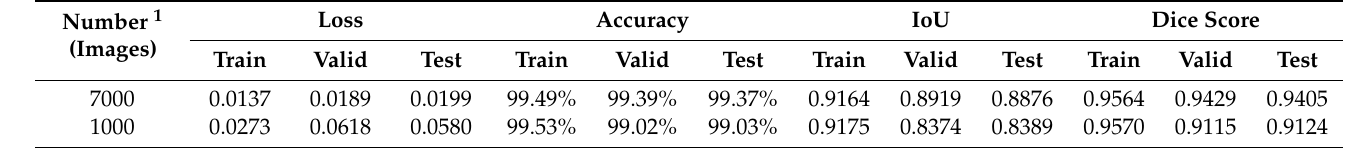
Figure A8. The loss and accuracy curves of Furlan2019 [43] using the synthetic dataset. ( a ) Refers to the epoch-wised loss curves in the training and validation sets. ( b ) Refers to the epoch-wised accuracy curves in the training and validation sets. Table A3 refers to the results of training NI-U-Net++ using different numbers of synthetic images. This research chooses about 50% (7000 images) and 10% (1000 images)